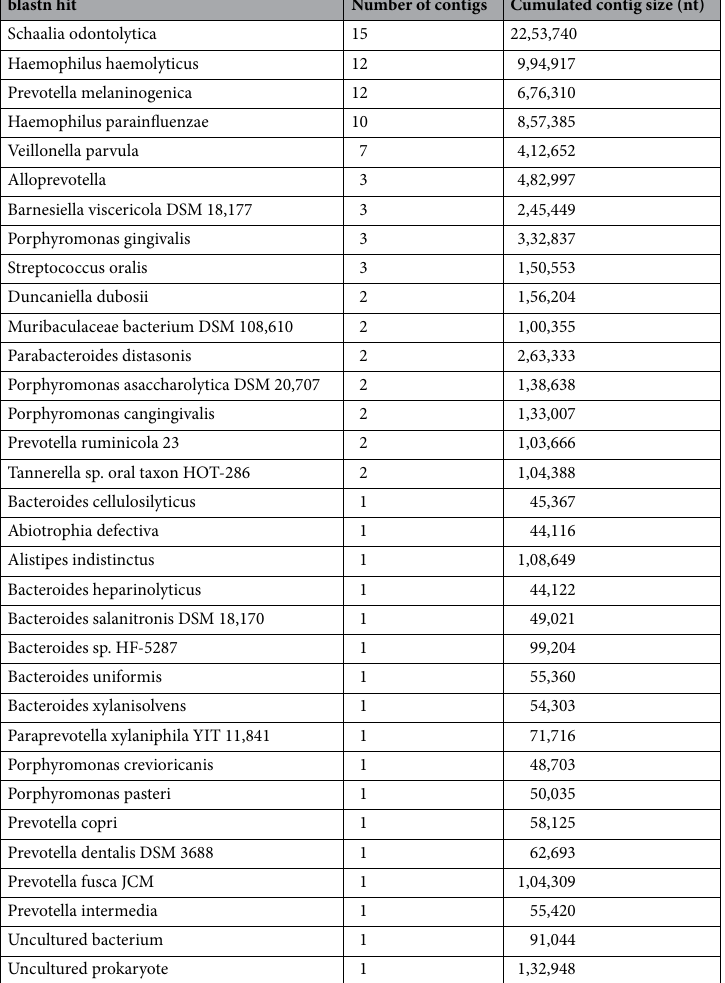
Table 2. Blastn hit on the 100 largest